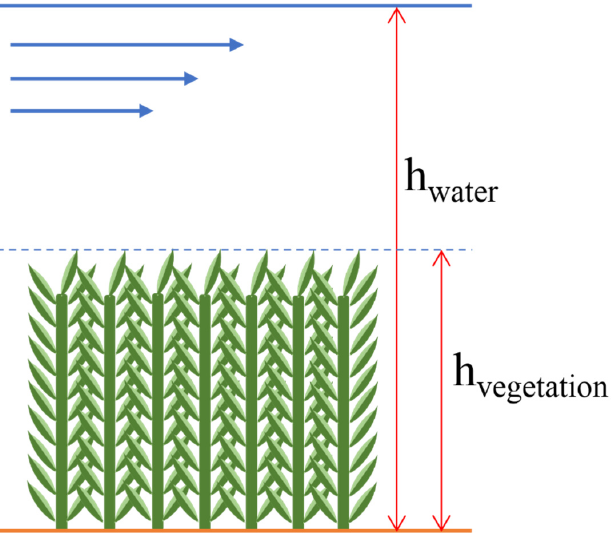
Figure 2. Scheme showing the degree of submergence of the vegetation. The code adaptation comprehends the creation of a new input file with the location of the grid cells with vegetation and the vegetation height in each cell. The model then calculates the pixel-based roughness at every vegetated grid cell for each loop of the simulation, based on the degree of submergence of vegetation using the formula pre- sented in Equation (5), obtained from the analysis of the relationship between the two parameters by the Japan Institute of Country-ology and Engineering [40]. The data pre- sent in [40] was obtained by field experiment, and the equation was obtained from re- gression analysis using MATLAB. The analysis produced a coefficient of determination (R²) of 0.88 and a root mean square error (RMSE) of 0.007. Unlike the dynamic roughness calculation method of Mohammadi and Kashefipour [13], which used only water depth and velocity threshold to define roughness, this model directly correlated the hydraulic resistance with the vegetation height.